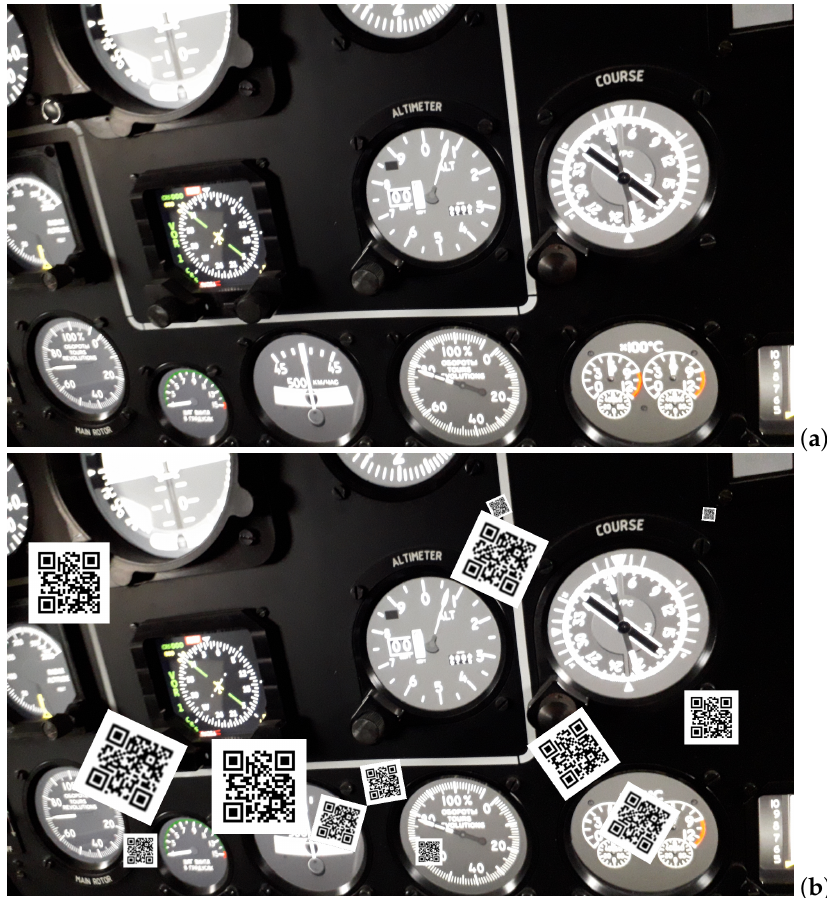
Figure 10. ( a ) Background image for the detect-and-decode scenario in maximal size (1920 × 1080); ( b ) background image inpainted with QR codes (at MTF50 = 0.4) at all sales used in the research in random locations and rotations (note that, in experiments, they occur one at a